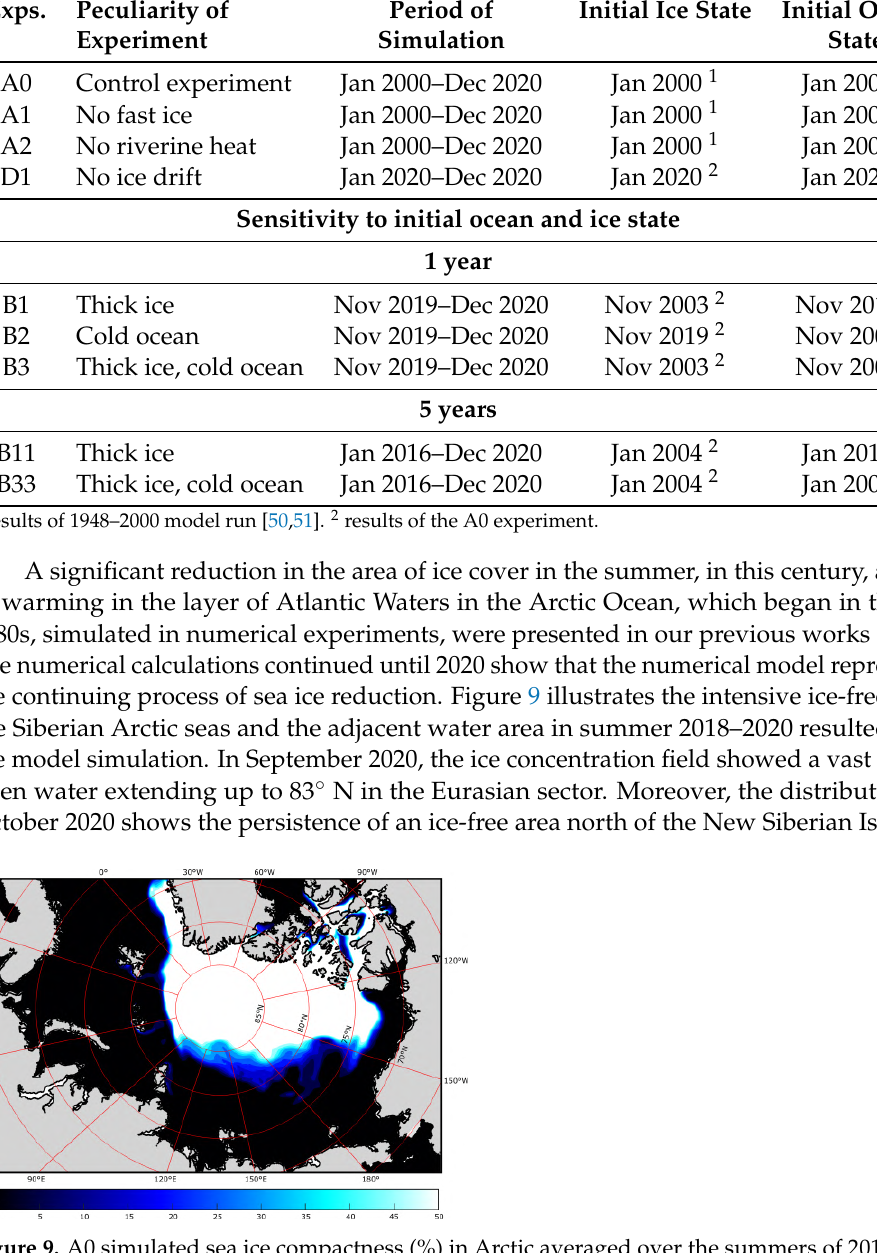
Figure 9. A0 simulated sea ice compactness (%) in Arctic averaged over the summers of 2018–2020. White areas present ice with compactness exceeding